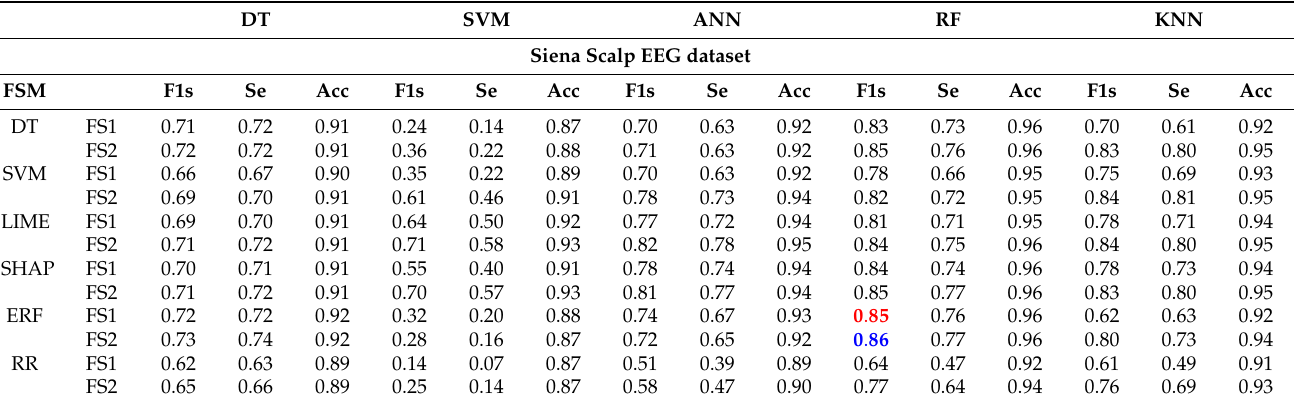
Table 9 shows that classifiers accounting for the best performances, RF and KNN, 0.84